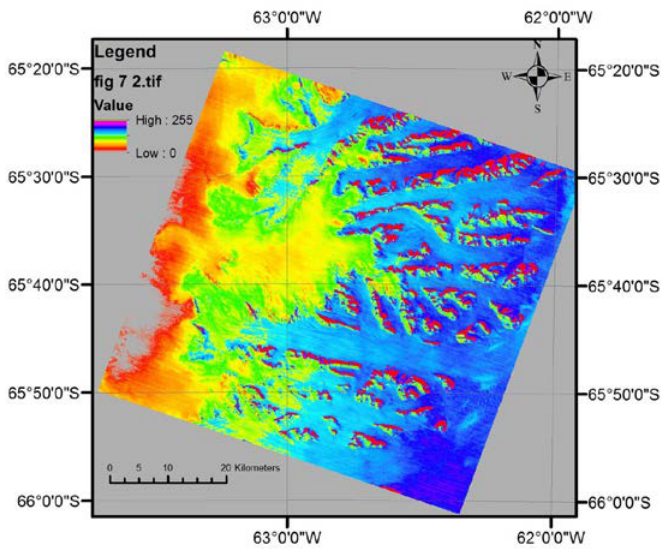
Figure 7. Image map of (band11*band11/band10*band 12=R), (band13/band14=G) and (band12/band13=B) of ASTER TIR